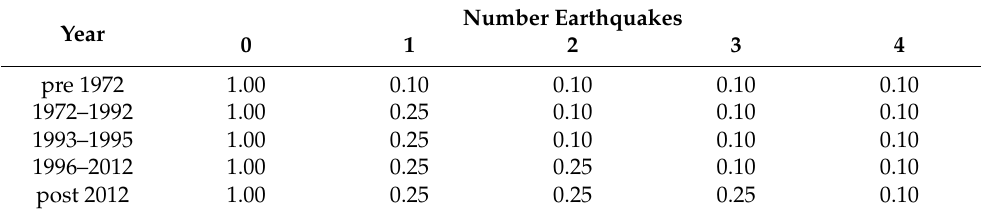
Table 3. Factor B for adobe buildings.